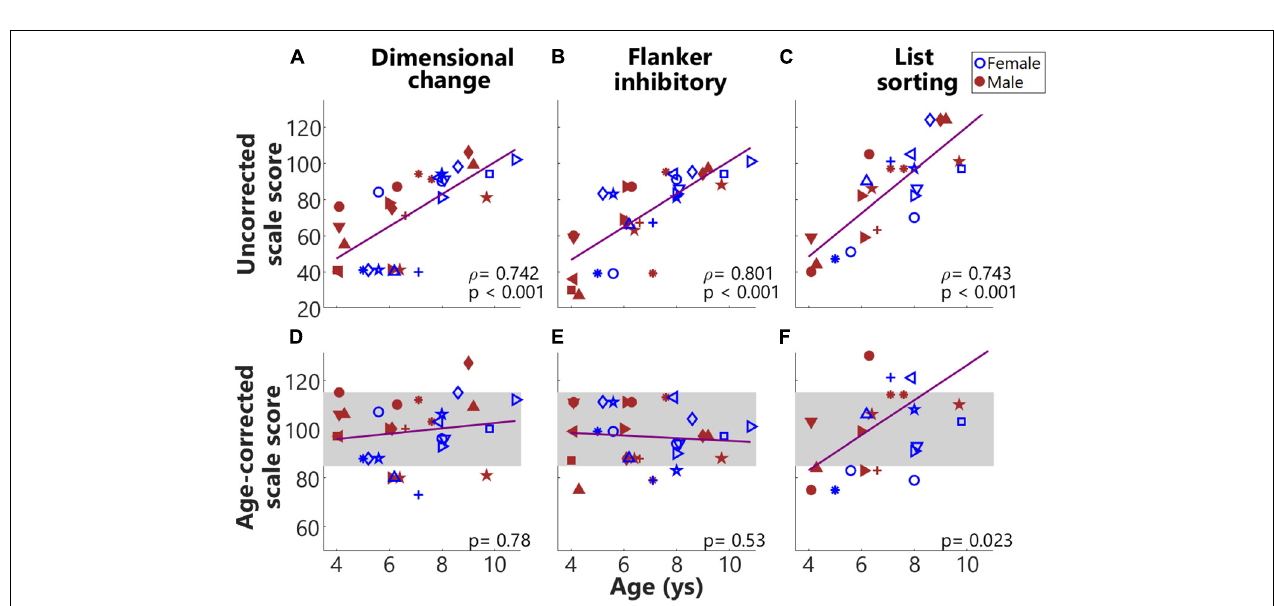
FIGURE 4 | Results from NIH toolbox. (A–F) From left to right, each column plots results from the Dimensional change card sort test, Flanker inhibitory attention and control task, and List sorting working memory test. The top and bottom rows show uncorrected and age-corrected scale scores, respectively. Across panels, the same symbols with colors (blue for females and red for males) were used to indicate results from the same individuals. The gray rectangles indicate the national average (100) ± 1 SD (15), i.e., 85–115 of the normed scores for the four